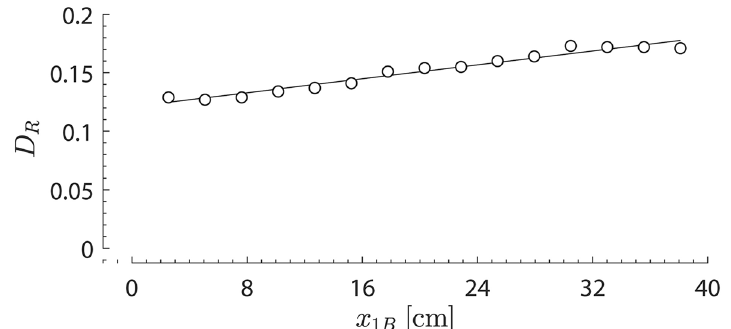
Fig. 8 Drag reduction ( D R ) results for the secondary fairing shape as a function of side wall height ( x 1 B ). Each secondary fairing geometry is defined by the following primary fairing shape variables: x 1 A x 2 A = 0.0 , and x 3 A = 191